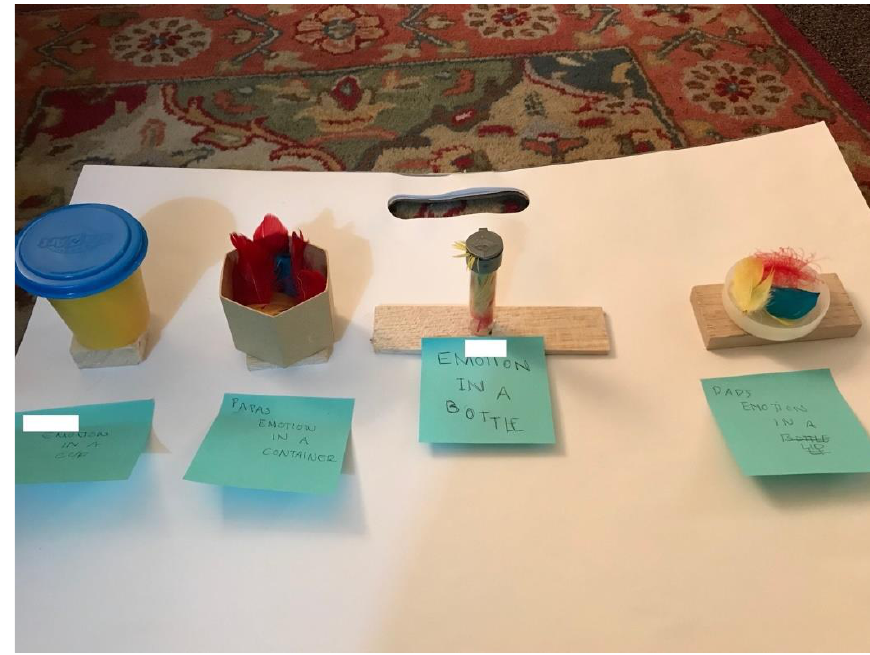
Figure 5. A’s emotions in a bottle (private practice individual art